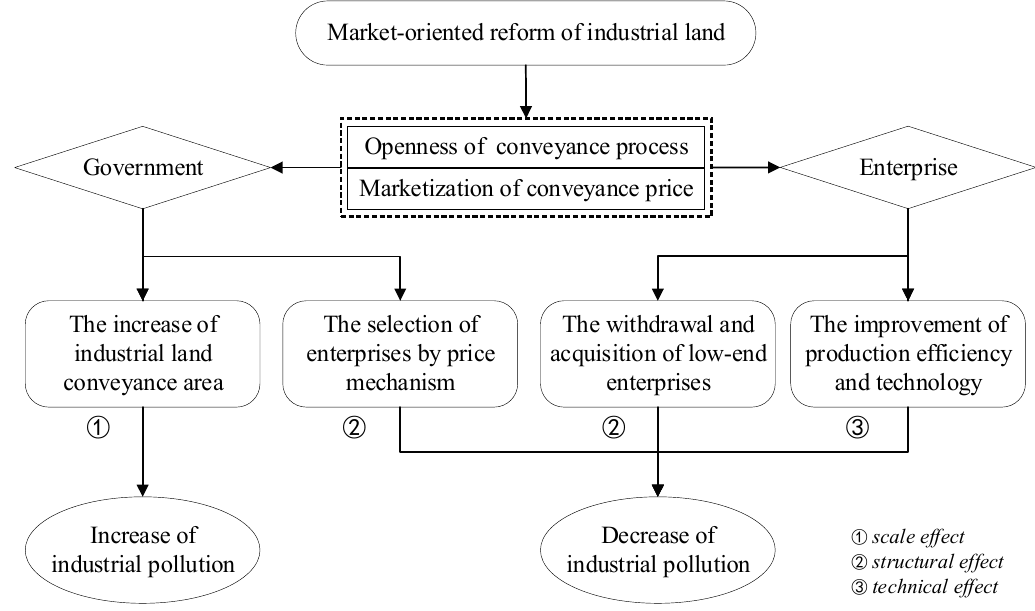
Figure 2. The theoretic framework of urban industrial land marketization and industrial pollution.